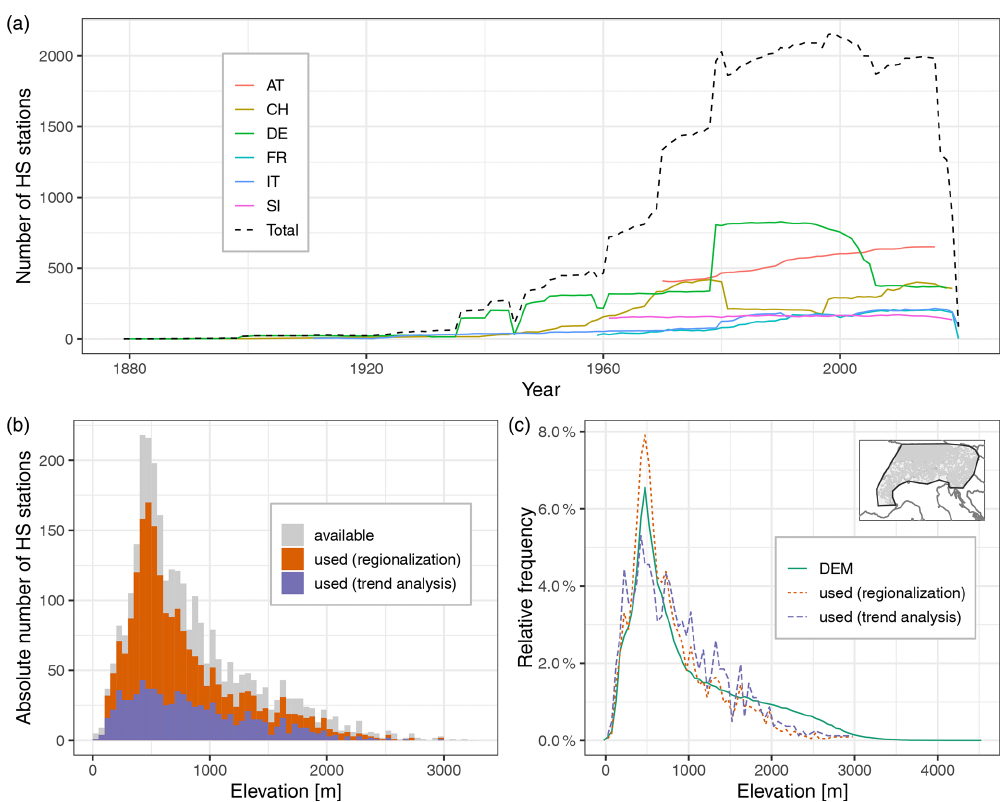
Figure 2. Overview of temporal data availability and station elevation. (a) The number of stations with daily data (before gap filling) is shown per year and country, as well as a total sum for the whole Alpine region. Stations are included in the count if they have at least one non-missing observation in the respective calendar year. This simple threshold was chosen because the aim of this figure is to show the availability and network abundance. Country abbreviations are like in Table 1. (b) The elevational distribution of snow depth (HS) stations in absolute numbers. For the histogram, 50m bins were used. (c) Comparison of the relative elevational distribution of the station locations vs. a digital elevation model (DEM). The distribution of the stations is shown in relative terms using the same bin width (50m) as in the histogram in (b) but normalized to show the relative frequency instead of absolute numbers and displayed as lines instead of bars. This is compared to the elevation for the whole area spanned by the stations (see polygon in inset map; area was outlined manually along the stations), which is extracted from the SRTM30 DEM (Shuttle Radar Topography Mission; ∼ 1km